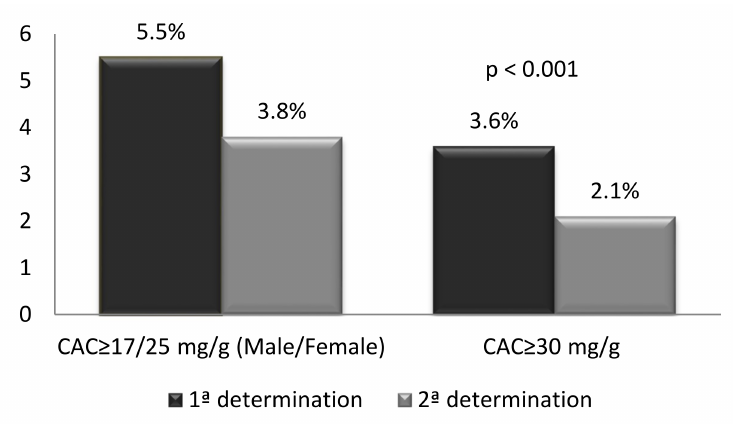
Figure 3. Prevalence of early kidney disease according to cut-o ff values.